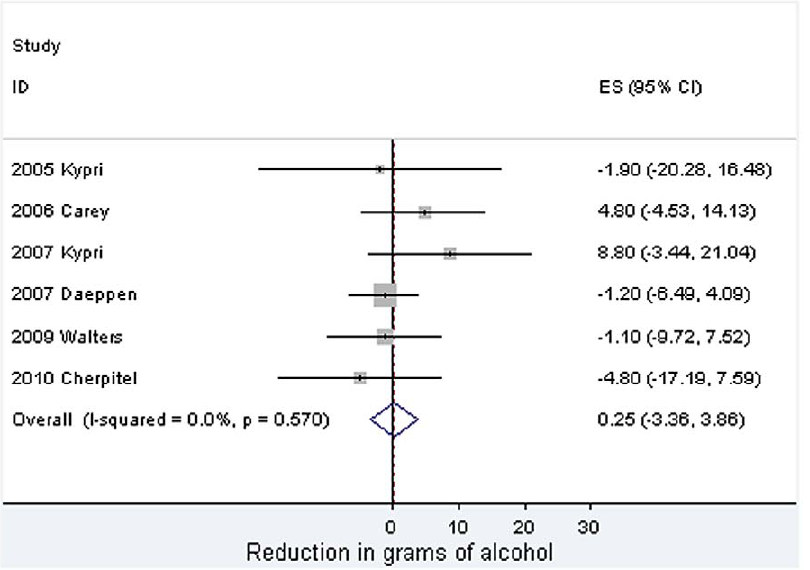
Figure 3. Meta-analysis of the effects of answering questions on quantity per drinking day.